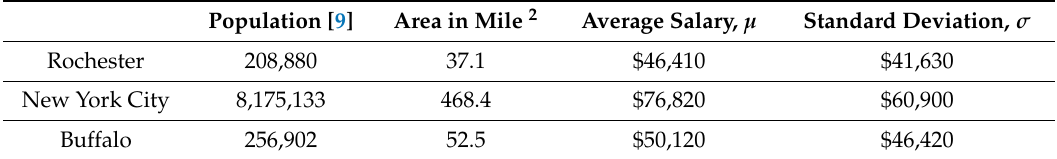
Table 1. Salary and demographic information of Rochester, Buffalo, and NYC.